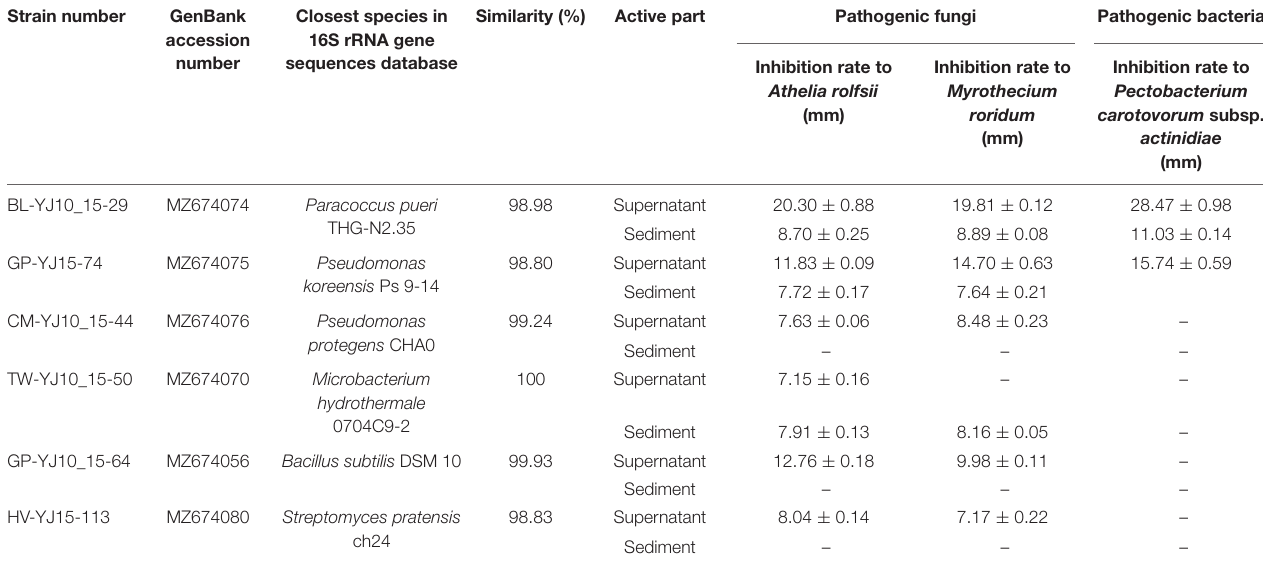
TABLE 1 | Endophytic strains that showed antimicrobial activity against at least one of three phytopathogens (diameter of filter paper, 6